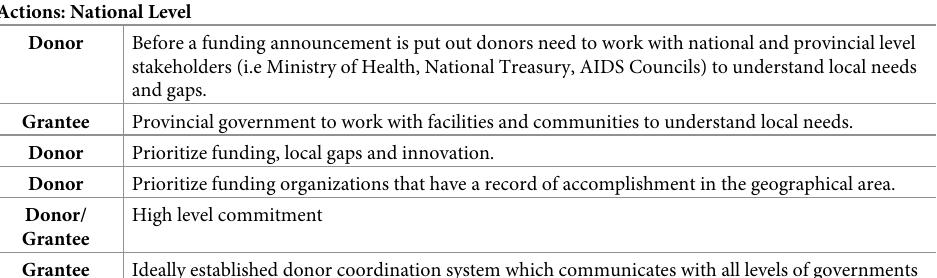
Table 3. Prior to program